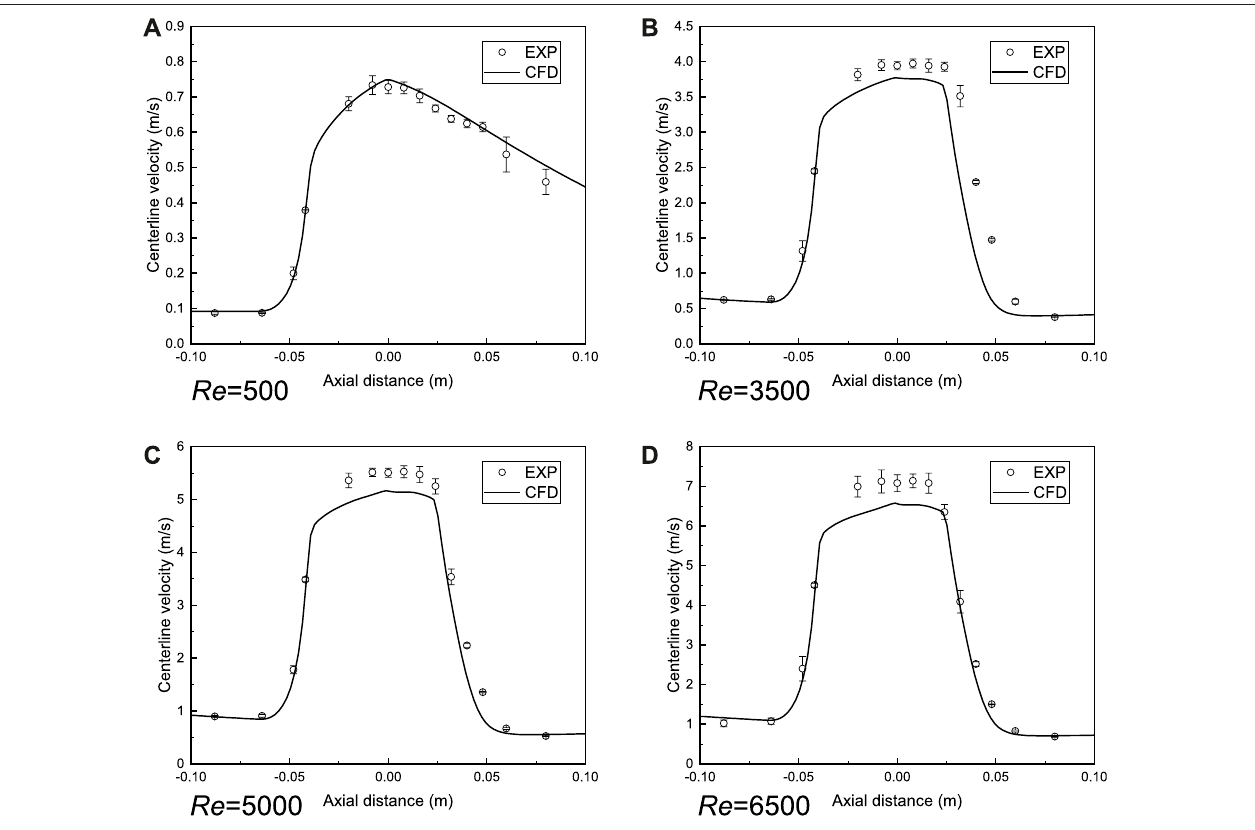
FIGURE 5 | Validation of blood fl ow model in FDA benchmark nozzle. (A) Laminar model. (B – D) Shear-stress transport turbulence model (SST). The axial velocity along the centerline is close to the experimental measurement result (NCI Hub contributors, 2022) and it is reasonable to adopt the SST model to predict the turbulent blood fl ow in the FDA nozzle. CFD is the computational result and EXP indicates the experimental result.